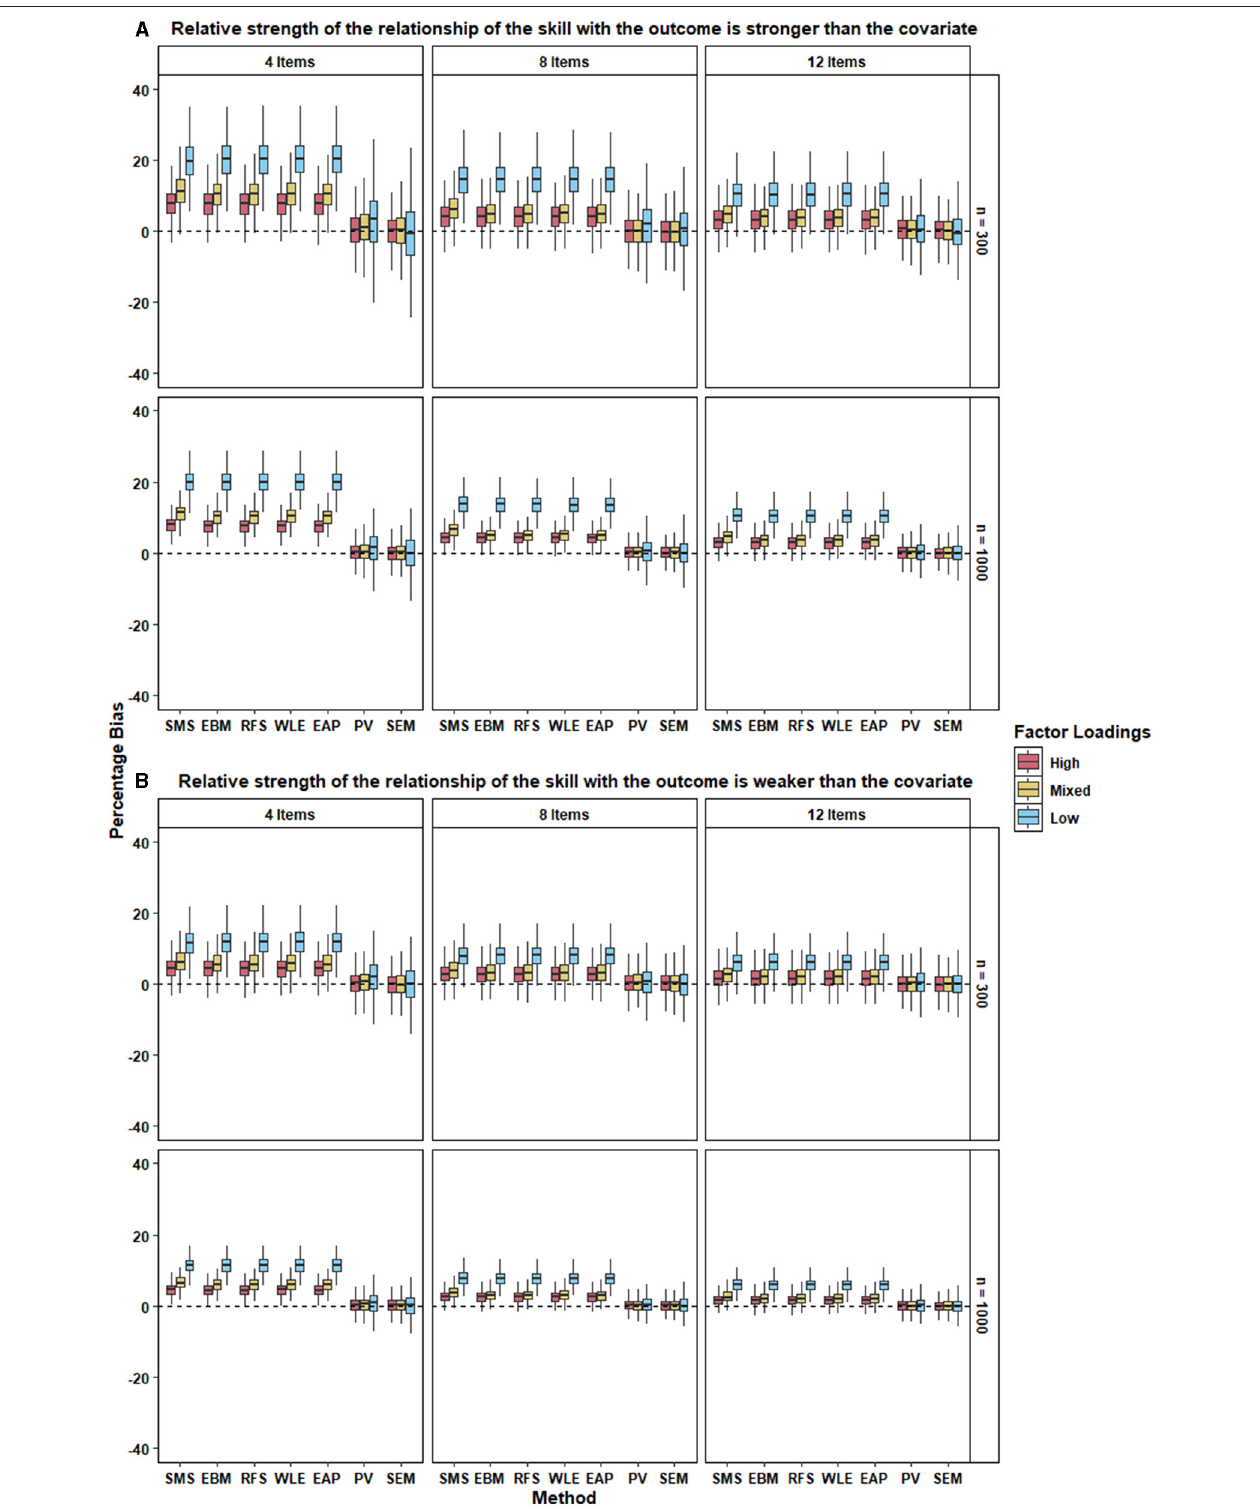
FIGURE 4 | The two panels, (A,B) , present the boxplot of percentage bias in the regression coefficient of the covariate for the different approaches under each condition when the relative strength of the relationship between the skill with the outcome is stronger and weaker respectively, than the covariate. 500 replications of each condition were used to create the